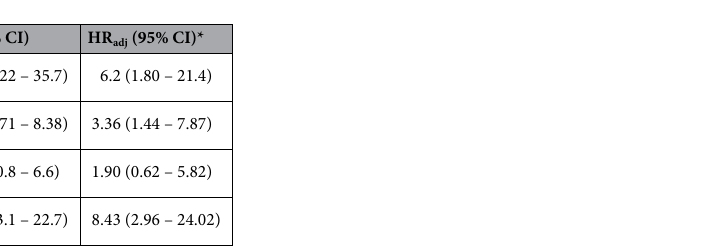
Table 2. Crude and adjusted Hazard Ratios (HR) for mortality. *Adjusted by creatinine (mg/dL) and eGFR (MDRD).